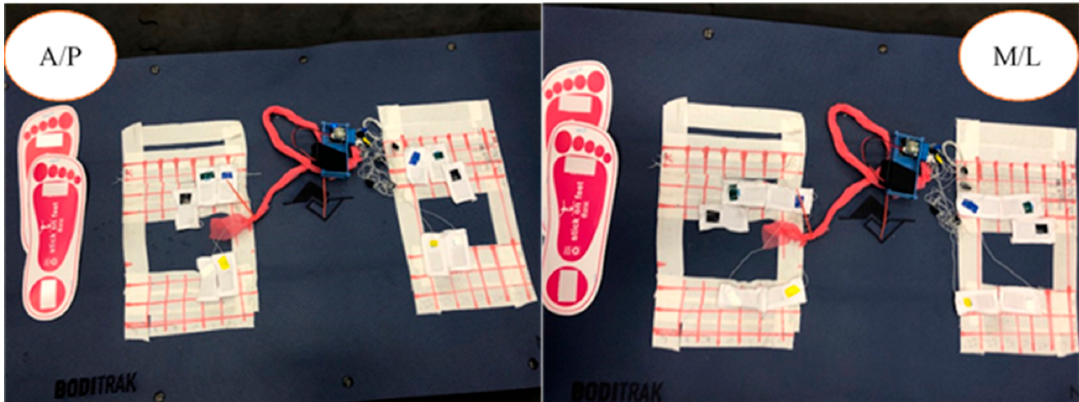
Figure 2. Sensor orientation on the gridded BodiTrak TM Vector Plate. Anterior–posterior (A/P) relates to the anterior and posterior direction of the sensors. Medial–lateral (M/L) relates to the medial-lateral direction of the sensors.